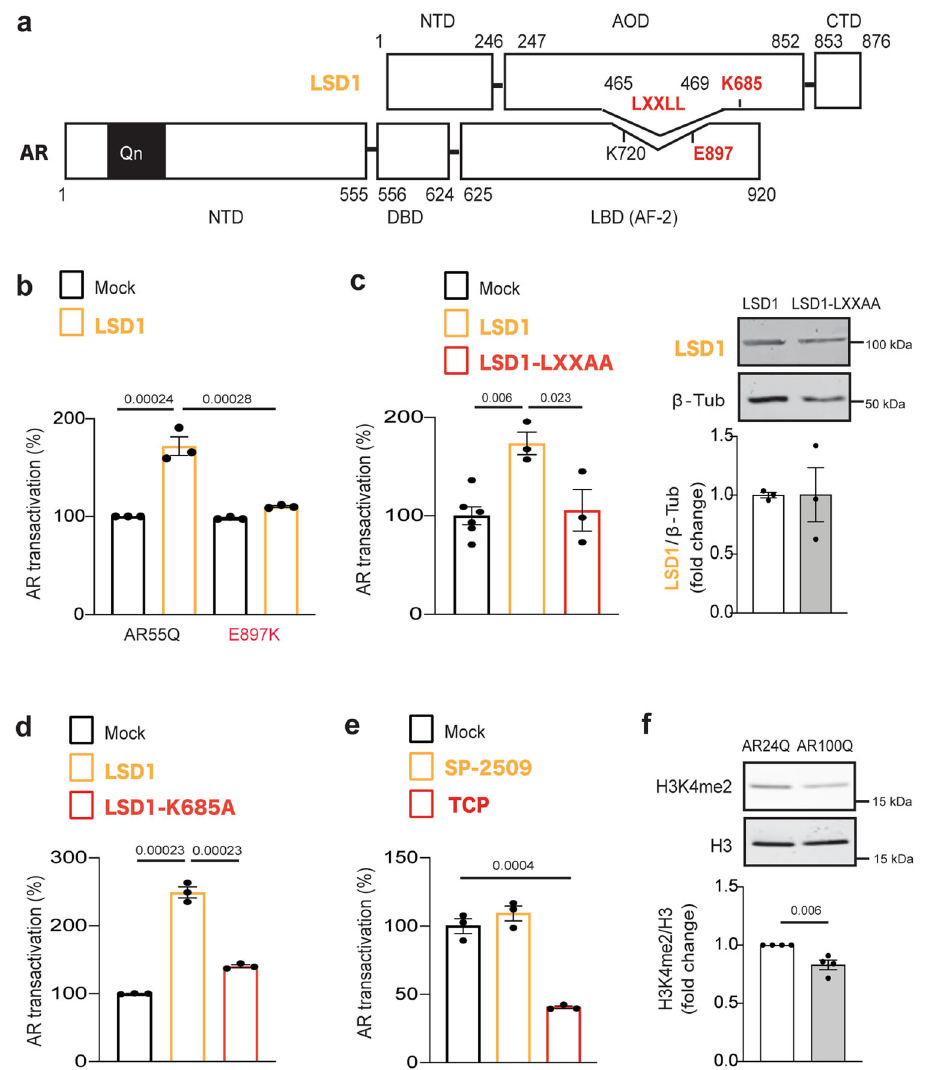
Fig. 3 | LSD1 requires the AR AF-2 surface and its catalytic activity to transac- tivate AR. a Scheme of AR and LSD1 modular domains and speci fi c motifs. Num- bers refer to AR NM_000044 and LSD1 NM_001009999. NTD, amino-terminal domain; DBD, DNA-binding domain; LBD, ligand-binding domain; AOD, amine oxidase domain; CTD, carboxy-terminal domain. b Transcriptional assay in HEK293TcellsexpressingAR55QortheAF-2mutantAR55Q-E897K,alone(mock)or with LSD1. Cells were treated with DHT (10nM, 16h; n =3 biological replicates). c (Left) Transcriptional assay in HEK293T cells expressing AR65Q alone (mock) or with either LSD1 or LSD1-LXXAA. Cells were treated with DHT (10nM, 16h; n =6 biological replicates mock, n =3 biological replicates LSD1 and LSD1-LXXAA). (Right) Western blot of LSD1 and LSD1-LXXAAexpression inHEK293Tcells. Shown